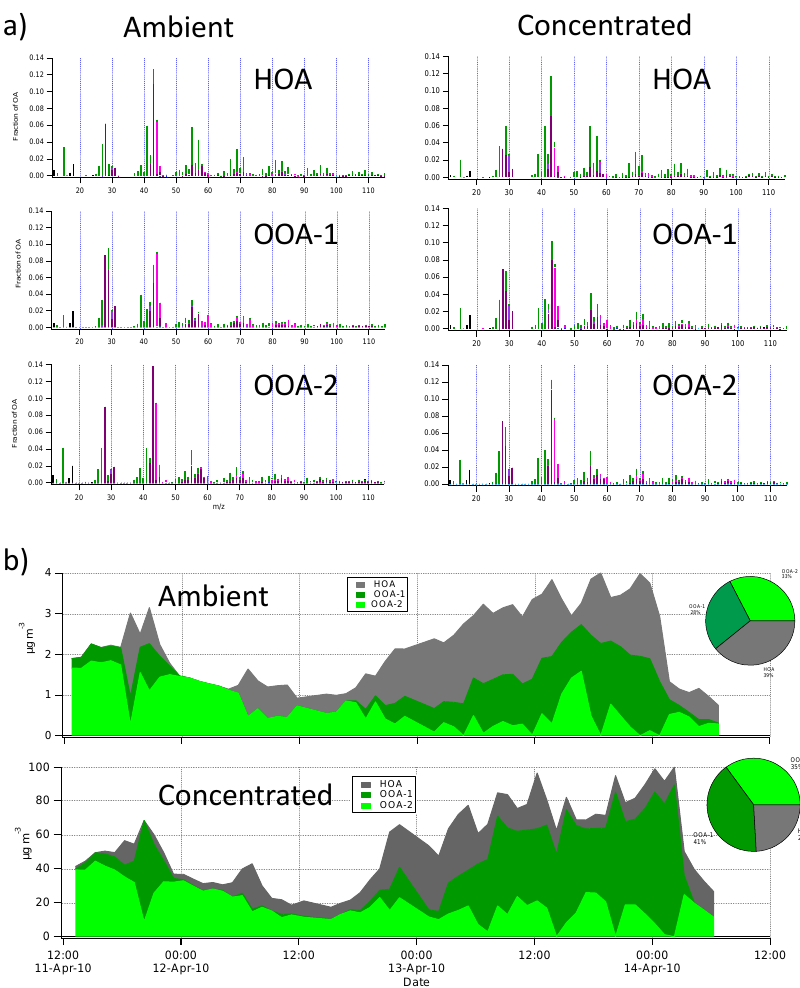
Figure 9. PMF factors for ambient and concentrated OA. Mass spectra (a) , and time series and average contributions to OA (b)